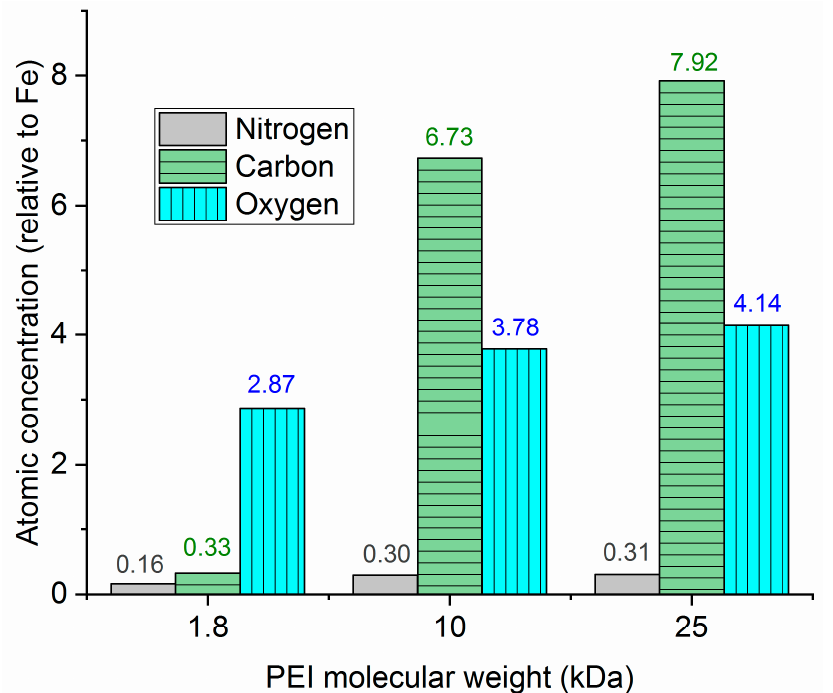
Figure 2. Relationship between the molecular weight of PEI and the relative atomic concentration of N (grey, no pattern), of N (grey, no pattern), C (green, horizontal pattern), and O (cyan, vertical pattern). Values are C (green, horizontal pattern), and O (cyan, vertical pattern). Values are normalized by the atomic concentration of Fe. The normalized by the atomic concentration of Fe. The values of the normalized concentrations are values of the normalized concentrations are indicated for clarity in performing a quantitative comparison. indicated for clarity in performing a quantitative